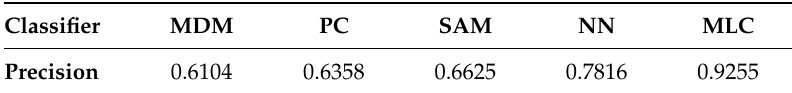
Table 3. Comparison of average precision among different supervised classifiers for LSMSS segment labeling.